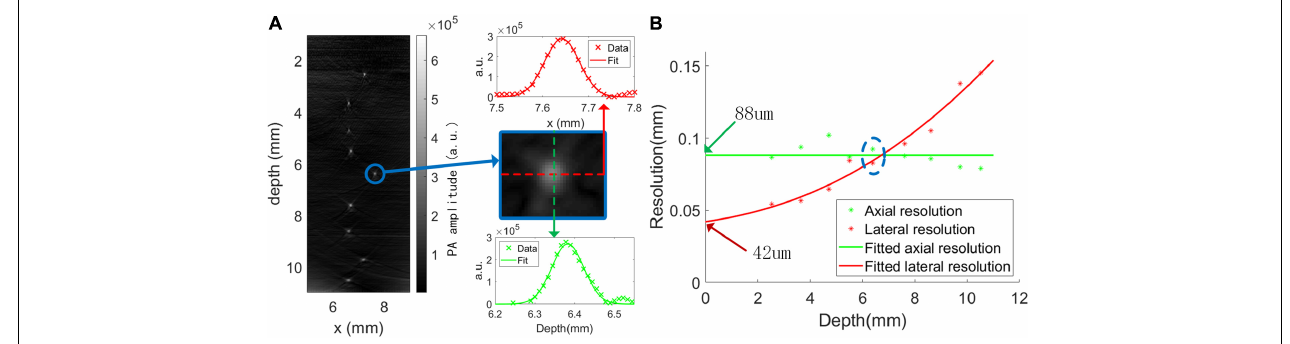
FIGURE 2 | Resolution measurements: (A) image of nine 9 µ m diameter tengsten wires. The resolution measurement process is illustrated with the bright spot inside the blue circle. The horizontal and vertical cross sections of the spot are shown in “ × ” and were fitted by Gaussian functions. The FWHM was then estimated. Red indicates lateral direction and green indicates axial direction. (B) Resolution as a function of imaging depth. The discrete points correspond to the bright spots in (A) .